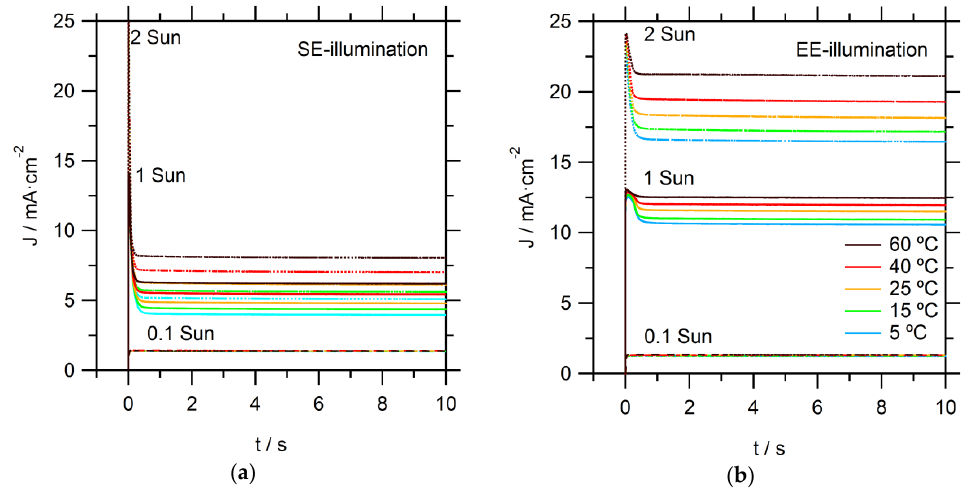
Figure 3. Photocurrent onset transients of a DSSC with Co(bpy) 3 /TPAA/MPN electrolyte for ( a ) SE- and ( b ) EE-illumination.